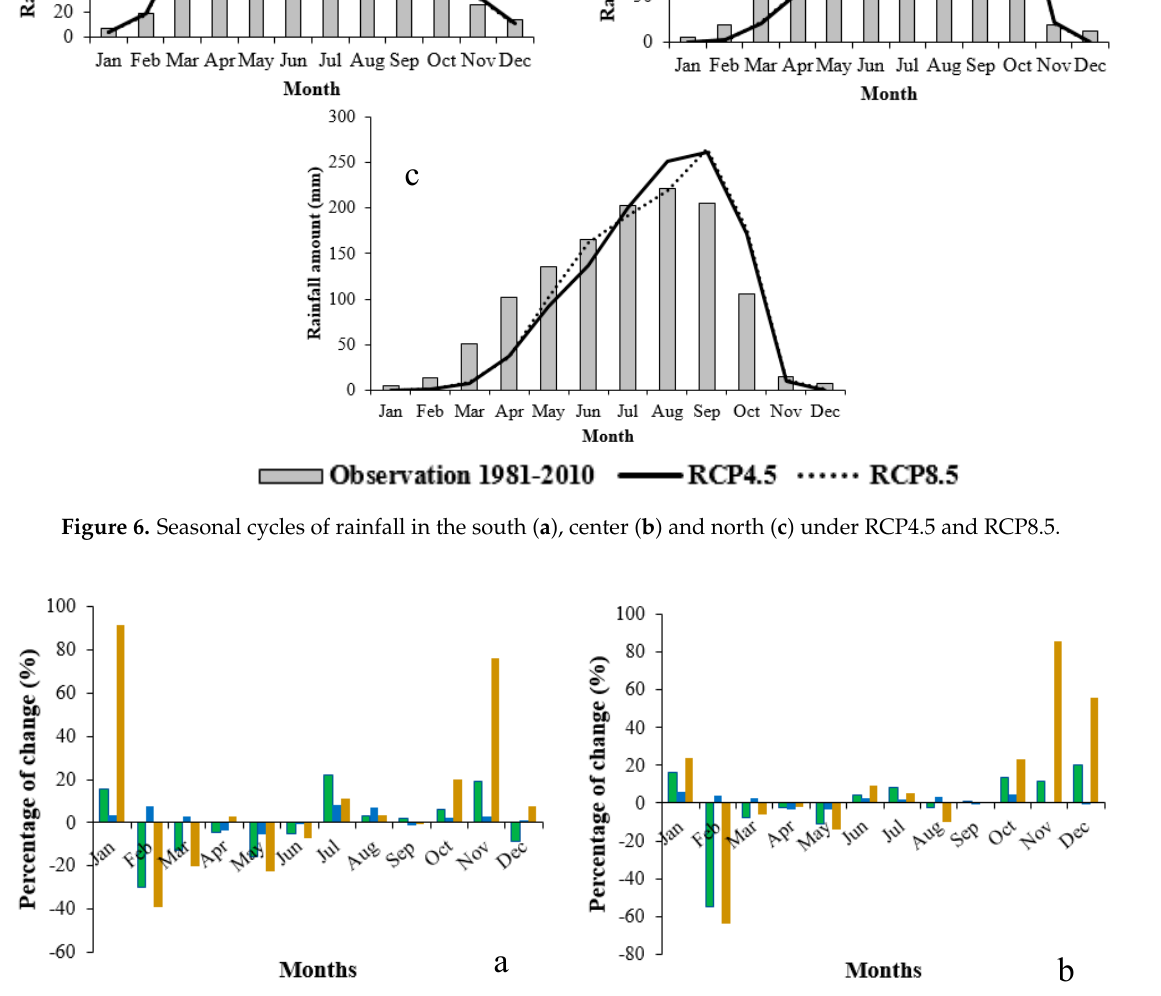
Figure 7. Expected change in rainfall seasonal cycles under RCP4.5 ( a ) and RCP8.5 ( b ).